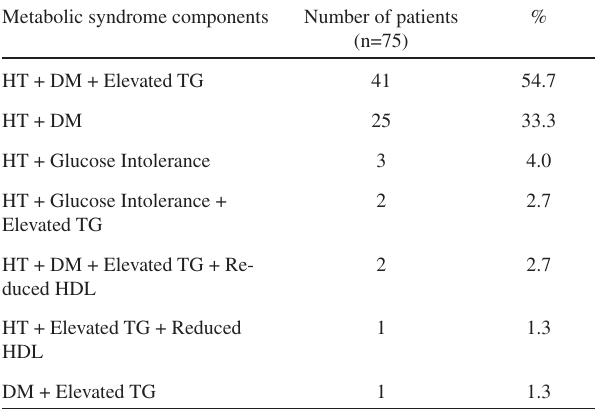
Table 5 - Distribution of frequencies of metabolic syndrome compo- nents, according to medical records of the 75 included